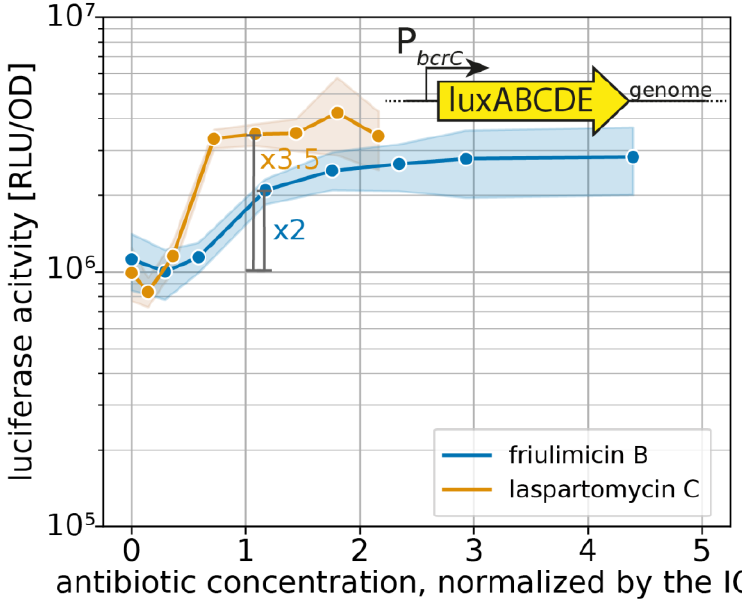
Figure 5. Sensitivity-normalized dose-dependent activation of the σ M stress response as shown by bcrC promoter induction during friulimicin B and laspartomycin C attack. The antibiotic concentration is shown in relation to the IC 50 of the respective antibiotic. The induction at the IC 50 is indicated in grey, and the fold change is given. The induction at the IC 50 is indicated in grey, and the fold change is given. Measurements were taken 30 min after antibiotic challenge. Shaded areas depict 95% confidence intervals.